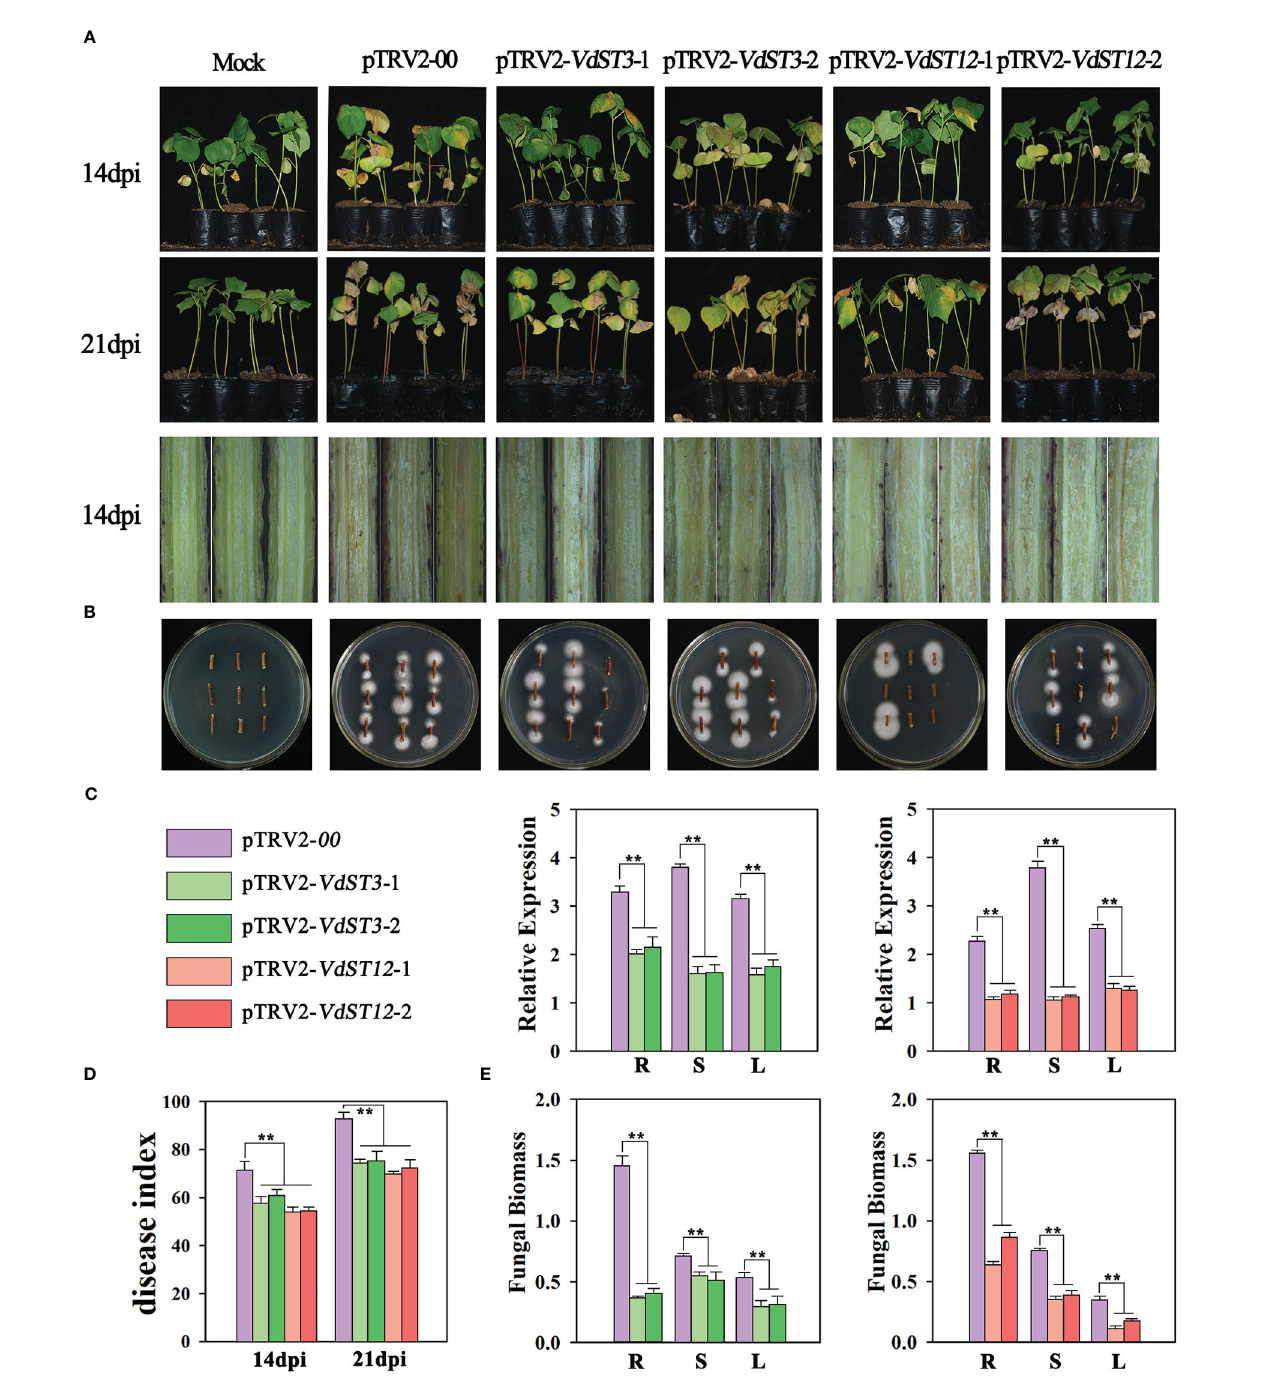
FIGURE 4 Functional assessment of VdST3 and VdST12 in the pathogenicity of V. dahliae by TRV-based HIGS. (A) Fungal infection symptoms of HIGS treated seedlings (pTRV2- VdST3- 1, pTRV2- VdST3- 2, pTRV2- VdST12 -1 and pTRV2- VdST12 -2) at 14 and 21 dpi. (B) Fungal recovery from the stem segments of HIGS treated seedlings. Stem segments were harvested at 14 dpi, plated on PDA medium and incubated at 25°C. Photos were taken at 7 days post incubation. (C) The expression level of VdST3 and VdST12 in HIGS treated seedlings at 21 dpi by qRT-PCR analysis. Total RNA was isolated from roots (R), stems (S) and leaves (L) of HIGS treated seedlings at 21 dpi. The cotton tubulin gene was used as the internal reference. (D) Disease index of HIGS treated seedlings at 14 and 21 dpi. (E) qRT-PCR measurement of fungal biomass in HIGS treated seedlings at 21 dpi. The data were statistically analyzed by